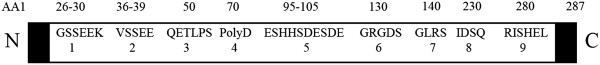
Selected structural domains and their corresponding locations in the human osteopontin-c.